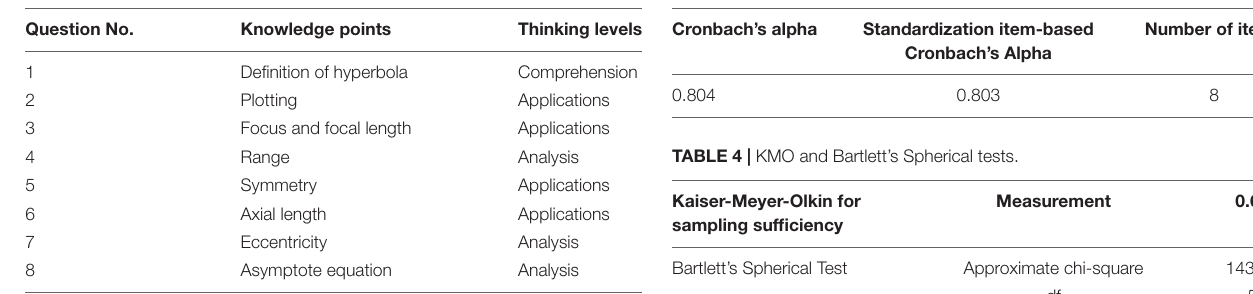
TABLE 3 | Reliability statistics.